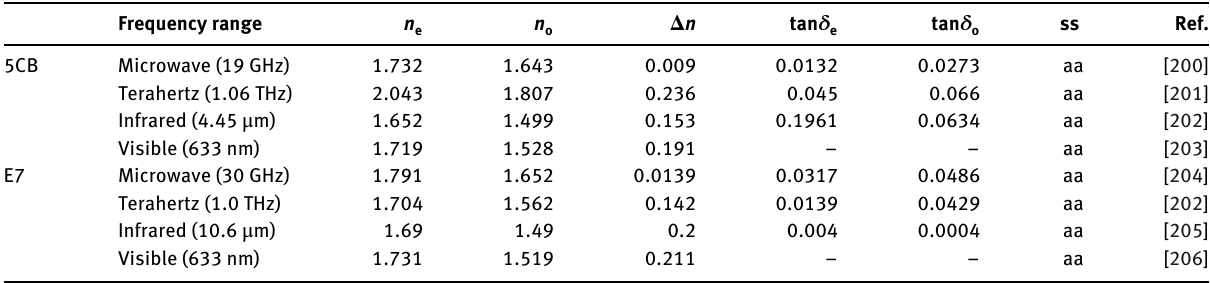
Table 1: Birefringent properties of several LCs (5CB, E7) operating from microwave to visible range. All dielectric properties were characterized at room